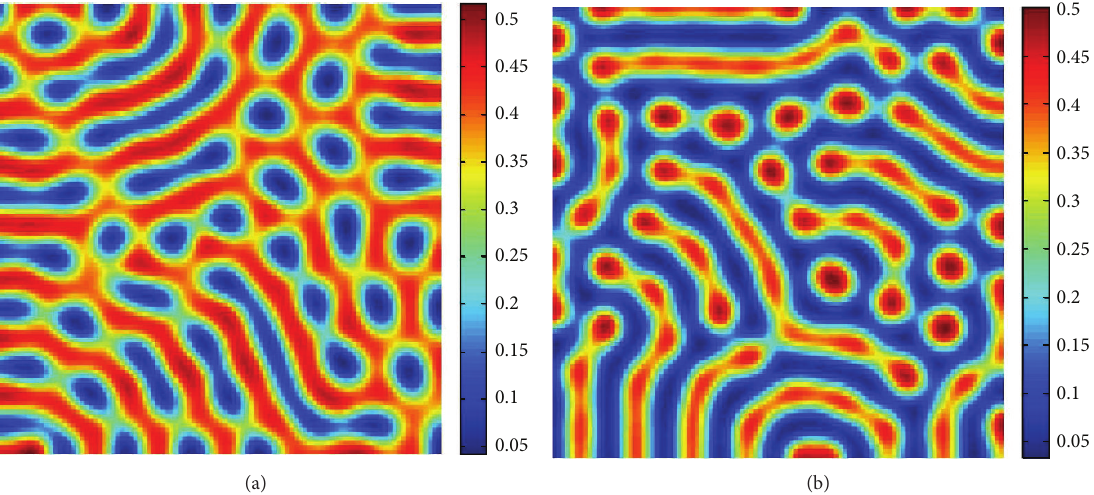
Figure 4: Typical Turing patterns of 𝑢 in model (7) with parameters 𝛼 = 1 , 𝛽 = 0.3 , 𝛾 = 0.3 , 𝑏 = 0.5 , 𝑐 = 0.6 , 𝑚 = 0.6 , 𝑞 = 0.35 , 𝑑 1 = 0.015 , and 𝑑 2 = 1 . (a) 𝑠 = 1.9 ; (b) 𝑠 = 2.45